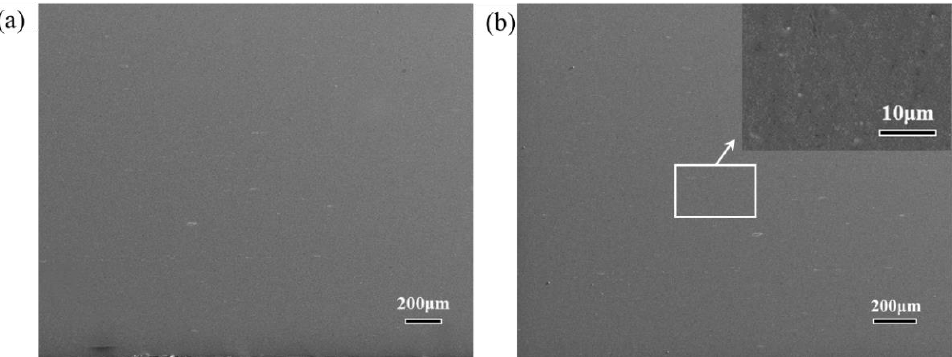
Figure 2. SEM micrographs of ( a ) pure Al and ( b ) Al/1.0 vol.% CNTs processed by 12 ARB. The typical TEM images of Al/1.0 vol.% CNTs nanocomposites processed over